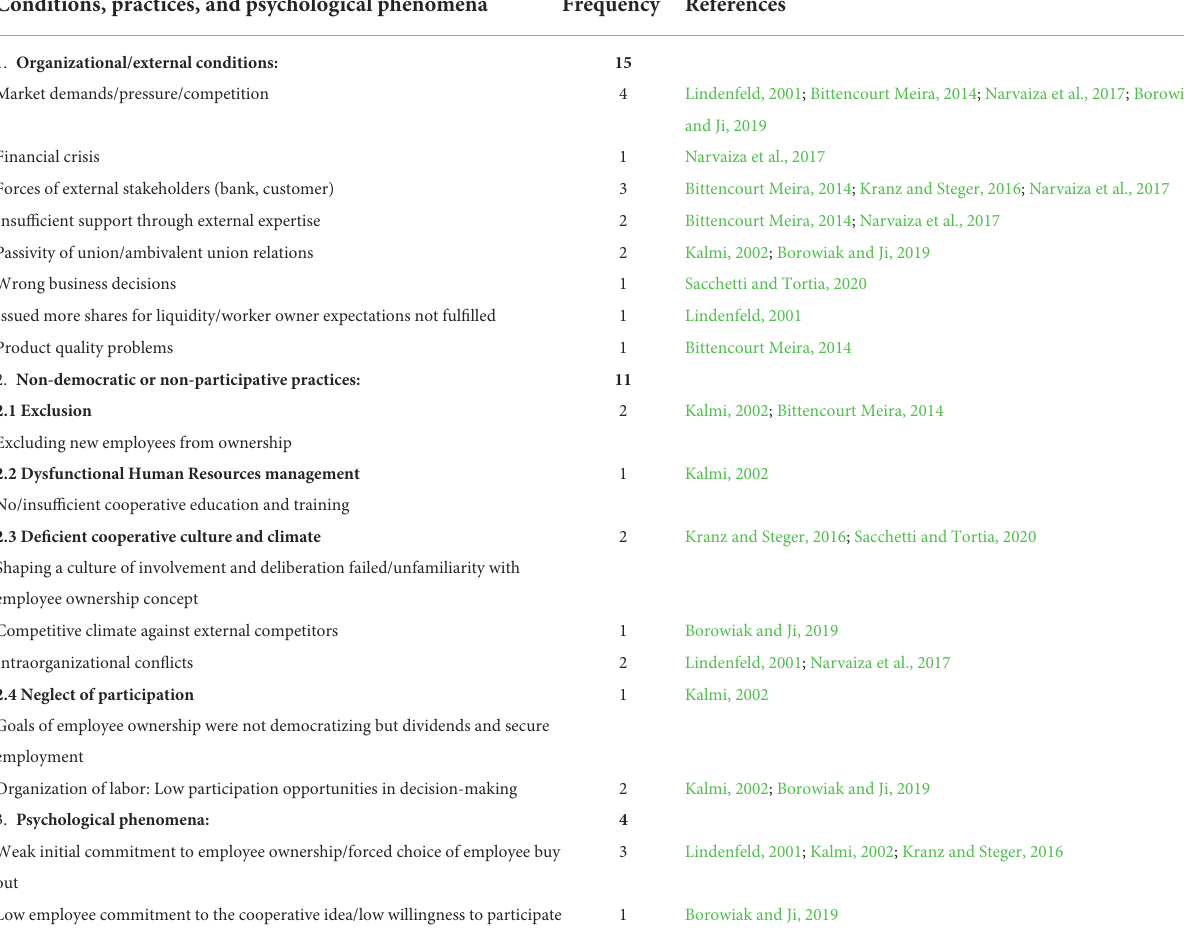
TABLE 2 Frequencies of conditions, practices, and psychological phenomena of all forms of full degeneration mentioned ( n = 7 enterprises). Conditions, practices, and psychological